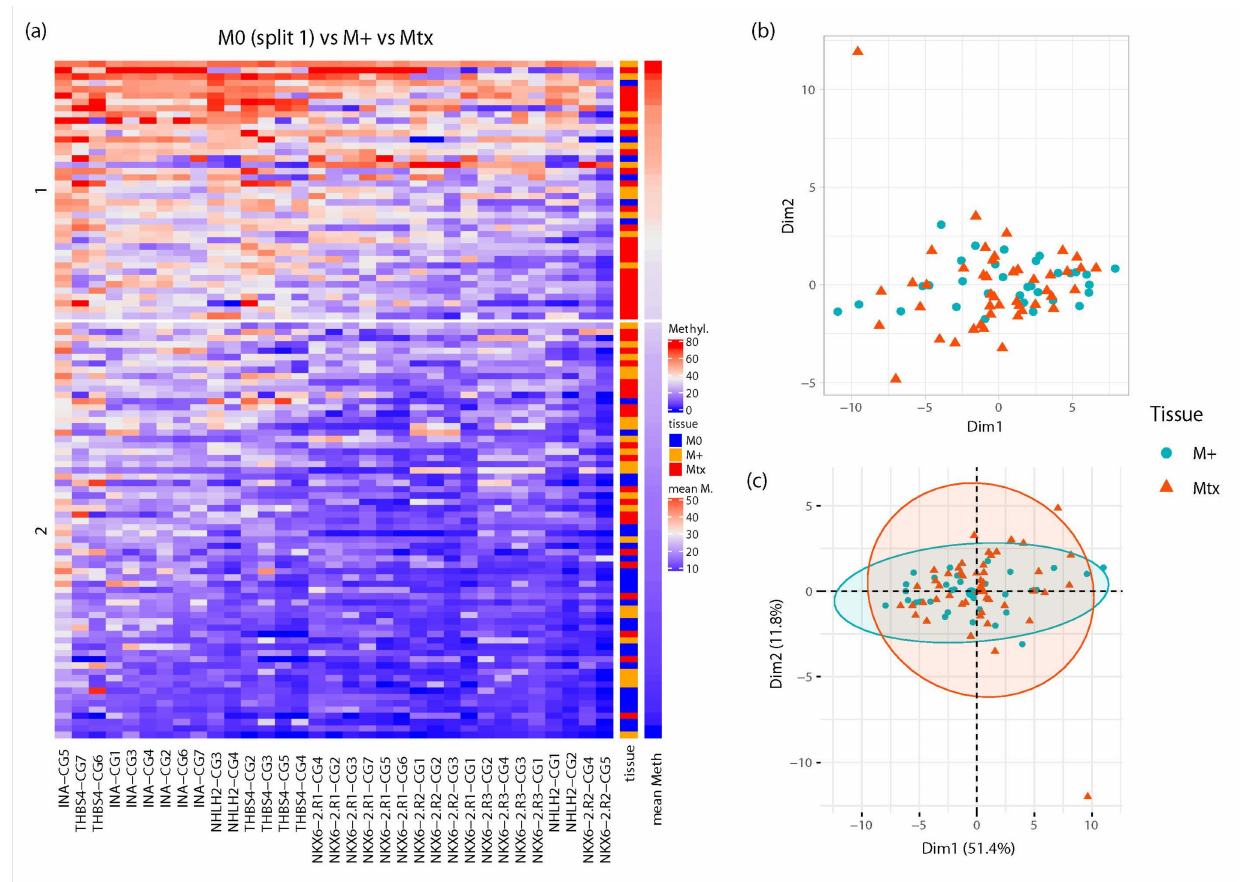
Figure 5. Similarity of INA , NHLH2 , NKX6-2 , and THBS4 CpG methylation patterns in metastasized primary tumors and metastatic renal tissues. ( a ) Heat map of unsupervised partitioning of CpG site- specific methylation in localized tumor, metastasized primary tumor, and metastatic tissue samples. Rows show patient/sample-specific relative methylation data with the specified color-coding. The two patient clusters (1,2) shown were obtained by k-means partitioning and consensus clustering with 100-fold bootstrapped resampling. Columns present CpG site-specific methylation data for the indicated genes. The type of analyzed tissue is indicated in the middle heatmap, including localized primary tumors (M0, blue), primary metastatic tumors (M+, orange), and metastatic tissue (Mtx, red), and the right heatmap shows the per sample (row-wise) average methylation (mean M). ( b ) Multi-dimensional scaling analysis of metastatic primary cancer (blue solid circles) and metastatic tissue samples (red solid triangles). ( c ) Principal component analysis of metastatic primary cancer (blue solid circles) and metastatic tissue samples (red solid